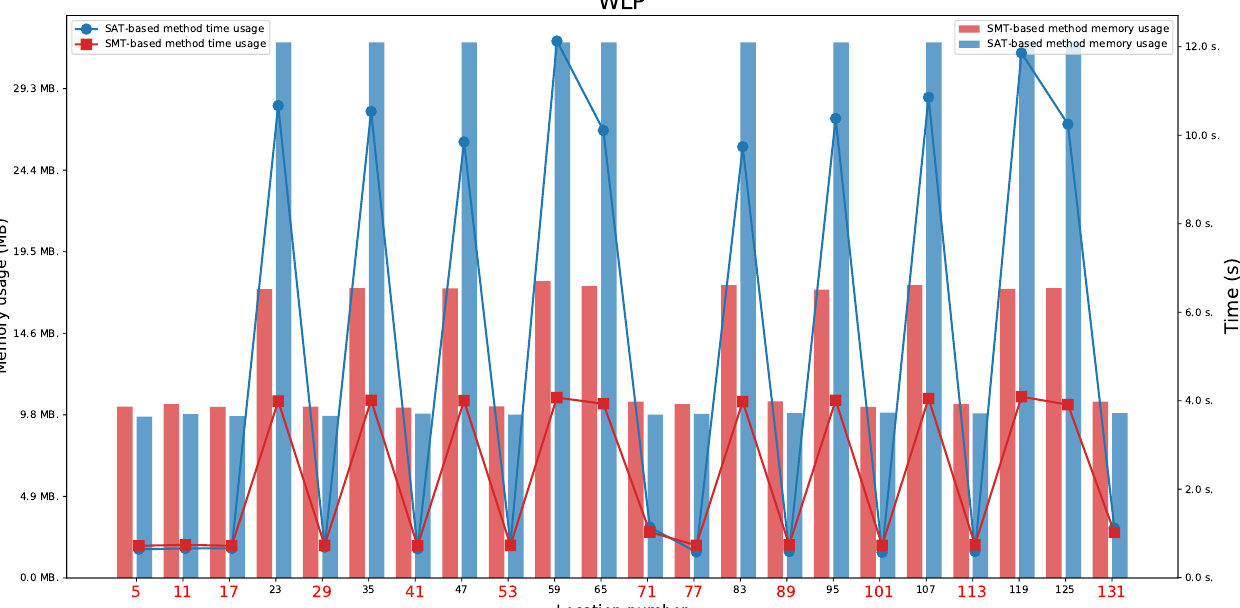
Figure 9. The WLP: Time and memory usage for checking the last locations’ reachability in each execution automaton for both lifetime values equal to 8. The reachable states are marked in red.